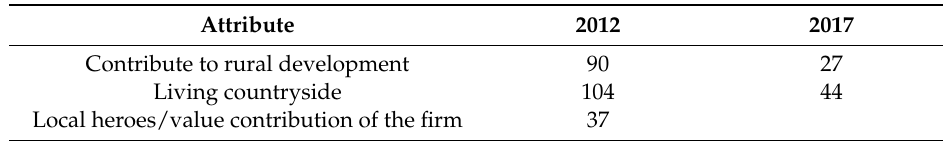
Table 5. The summary of the local and rural development attributes 1